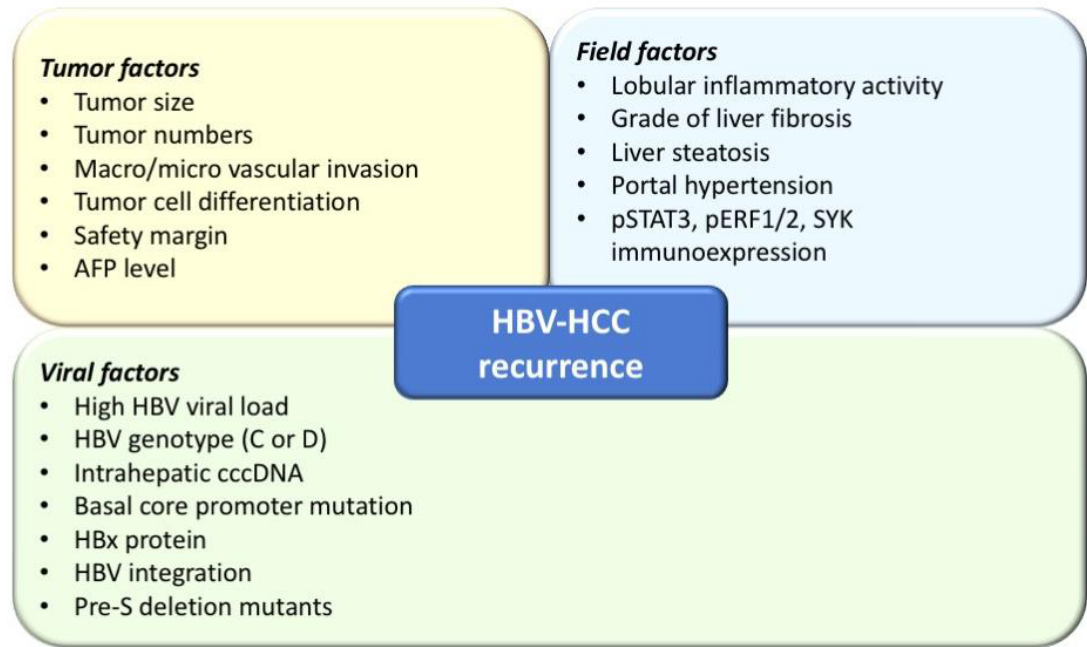
Figure 1. Risk factors associated with hepatocellular carcinoma (HCC) recurrence in chronic hepatitis B (CHB) patients.